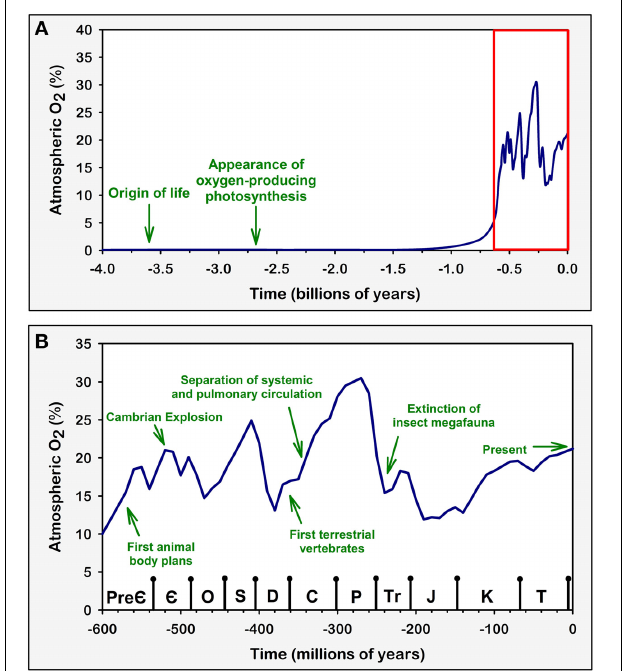
FIGURE 1 | Variations in atmospheric oxygen concentrations over geological time. Green arrows and texts represent major evolutionary and geological events that are believed to be in direct connection with atmospheric O 2 concentration (Graham et al., 1995, 1997; Dudley, 1998; Bishopric, 2005; Raymond and Segre, 2006; Fisher and Burggren, 2007; Koch and Britton, 2007; Harrison et al., 2010; Taylor and McElwain, 2010). Similar comparisons have been discussed previously (Koch and Britton, 2007). Arrows are positioned in time based on approximations derived from geological evidence. Atmospheric O 2 levels were estimated and plotted based on available geochemical studies (Berner, 2006; Olson, 2006; Raymond and Segre, 2006; Berner et al., 2007; Taylor and McElwain, 2010). (A) Atmospheric O 2 concentration across geological time. This representation includes the periods over which life first appeared on Earth and the evolution of oxygenic photosynthesis, which was responsible for the subsequent rise in atmospheric O 2 . (B) A zoom in on the region highlighted in red on (A) . This expanded view includes the time span ranging from the Ediacaran period of the late Pre-Cambrian to the present Quaternary period (not named in graph) of the Cenozoic Era. During these periods, atmospheric O 2 concentration varied greatly; these changes influenced the evolutionary trends of animal life, including the development of the cardiovascular and respiratory systems in vertebrates. Symbols on the bottom axis represent the geological Periods according to the 2009 Geologic Time Scale (Walker and Geissman, 2009). Pre- Є , Pre-Cambrian; Є , Cambrian; O, Ordovician; S, Silurian; D, Devonian; C, Carboniferous; P, Permian; Tr, Triassic; J, Jurassic; K, Cretaceous; T,